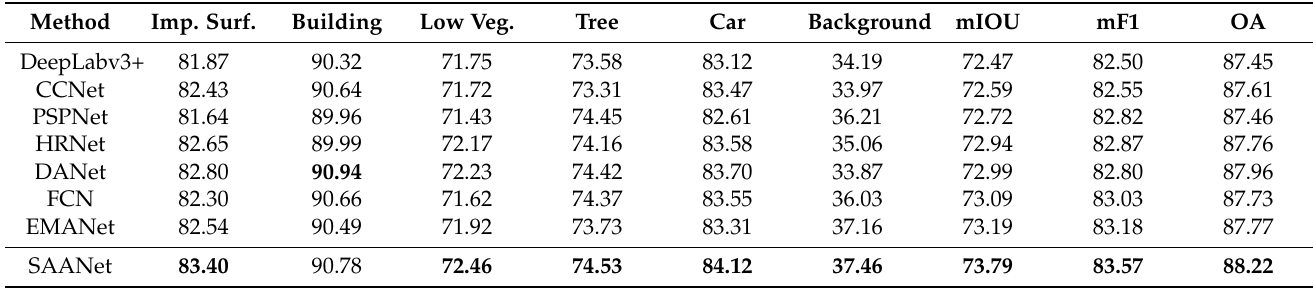
Table 2. Comparisons of different networks on ISPRS Potsdam dataset. Note that we choose the IOU as the metric of each category. The best results are shown in boldface.